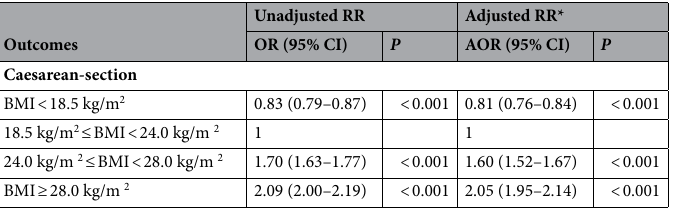
Table 3. Relationships between pre-pregnancy BMI and outcomes. **Pre-pregnancy BMI was adjusted for maternal age, ethnic group, education, area of residence, occupation, smoking, passive smoking, alcohol drinking, and sex of